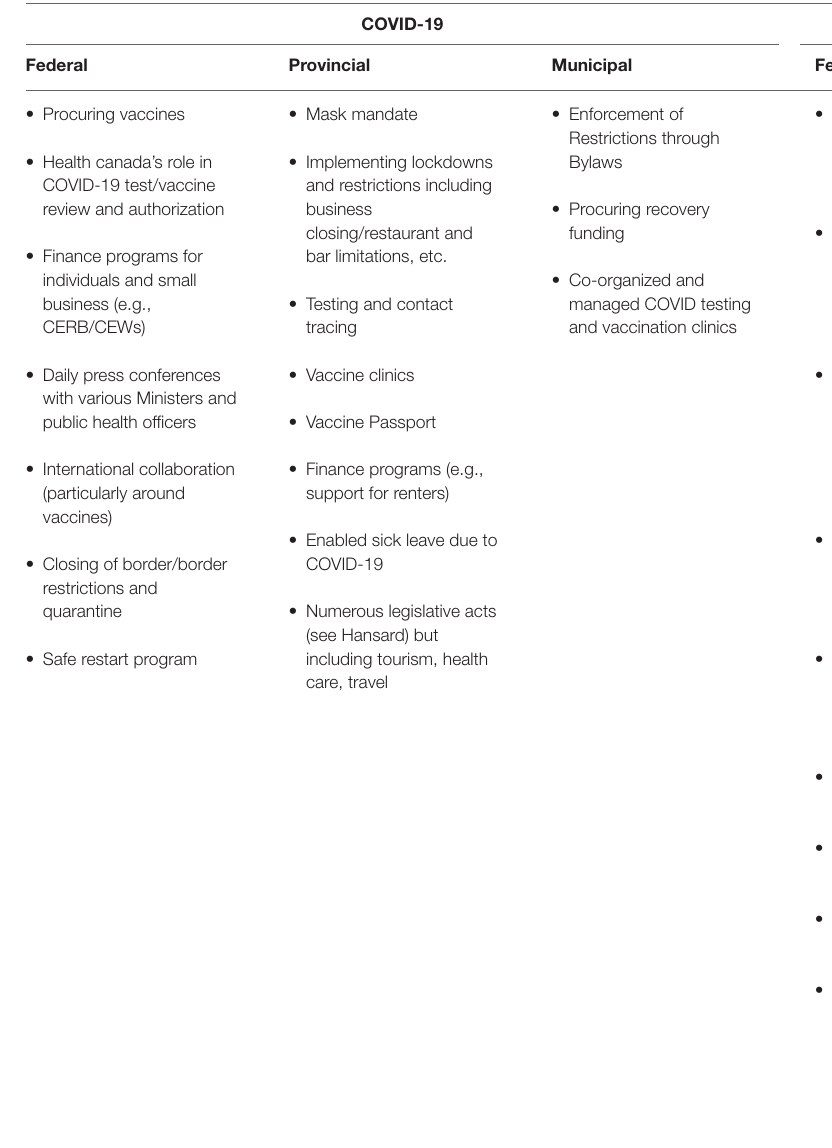
TABLE 2 | What information needs to be